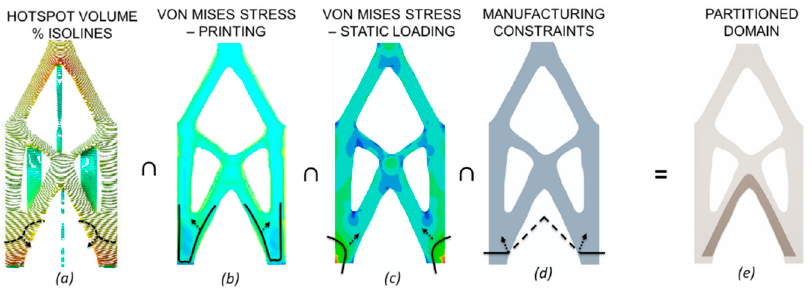
9 of 17 Figure 6. Hot spot contour plot from a process simulation of the optimized geometry. The inset shows